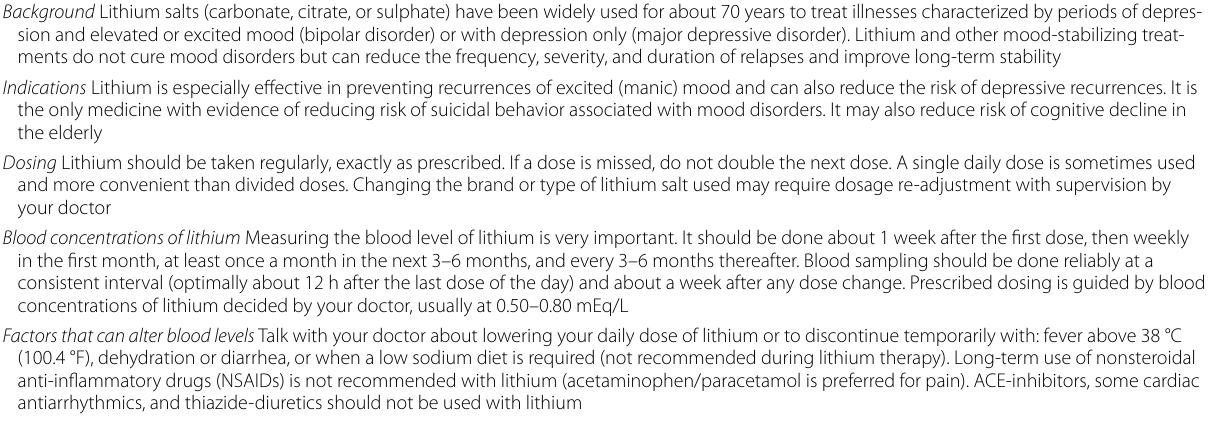
Table 1 Recommendations for patients treated with lithium and their prescribers Background Lithium salts (carbonate, citrate, or sulphate) have been widely used for about 70 years to treat illnesses characterized by periods of depres‑ sion and elevated or excited mood (bipolar disorder) or with depression only (major depressive disorder). Lithium and other mood‑stabilizing treat‑ ments do not cure mood disorders but can reduce the frequency, severity, and duration of relapses and improve long‑term stability Indications Lithium is especially effective in preventing recurrences of excited (manic) mood and can also reduce the risk of depressive recurrences. It is the only medicine with evidence of reducing risk of suicidal behavior associated with mood disorders. It may also reduce risk of cognitive decline